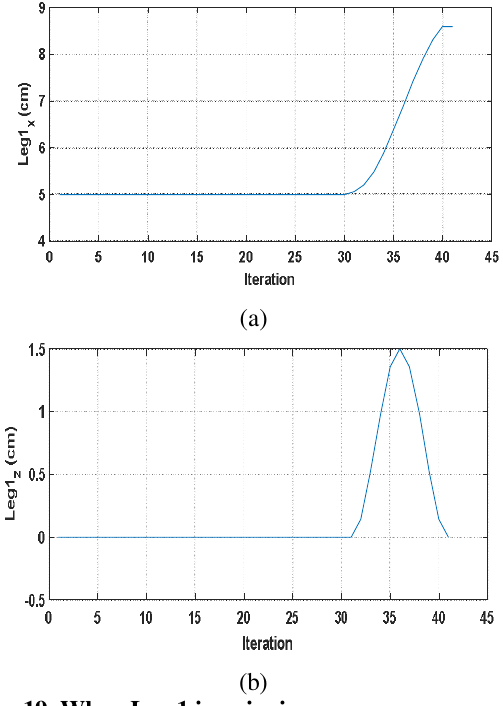
Fig. 19. When Leg 1 is swinging. (a) Leg 1 moved one step along X-axis. (b) Leg 1 moved one step along Z-axis. From above Figures it can be seen the following: 1. In Figure (16): leg4 tip is swinging and moving from (-5 cm) to (-3.5 cm) along X-axis and (1.5 cm) along Z-axis. 2. In Figure (17): leg2 swinging and moving from (5 cm) to (7.4 cm) along X-axis, also the height of the lifting tip is (1.5 cm) along Z-axis. 3. In Figure (18): leg3 swinging and moving from (-5 cm) to (-2 cm) along X-axis, also the height of the lifting tip is (1.5 cm) along Z-axis. 4. In Figure (19): leg1 swinging and moving from (5 cm) to (8.5 cm) along X-axis, also the height of the lifting tip is (1.5 cm) along Z-axis. As discussed in this paper, the quadruped walking along X-axis only while the Y-axis is fixed, there is no changing in the Y-axis during the walking of the quadruped robot. Figure (20) showing this